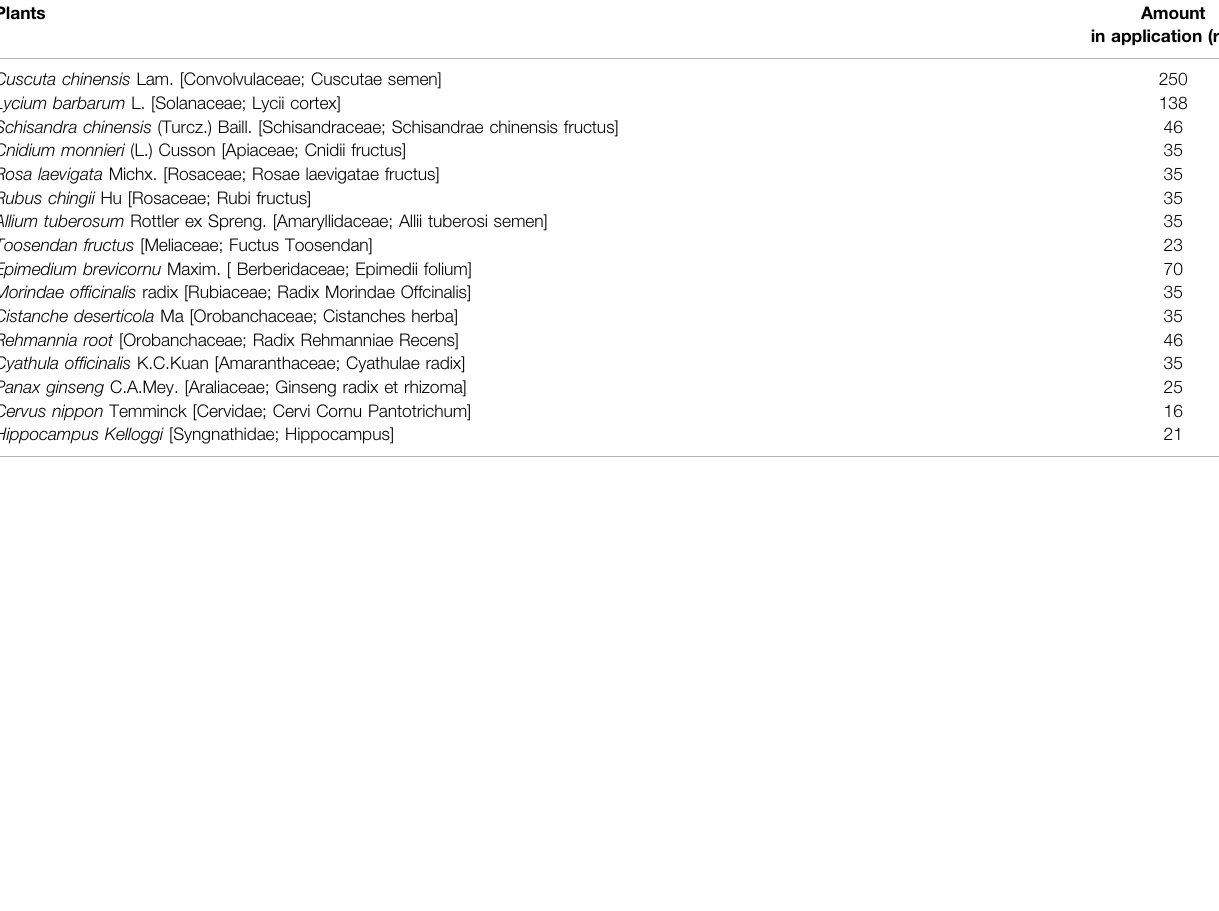
TABLE 1 | The ratio of the plants present in the preparation of BZBS. Plants Amount